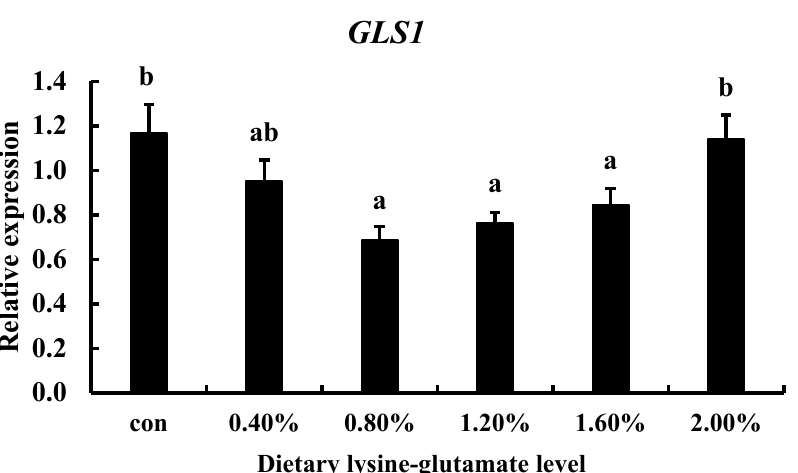
Figure 9. TCC gls1 gene expression with different supplemental lysine-glutamate peptide (mean ± SE of relative expression; n = 9). Different letters represent significant difference ( p < 0.05).